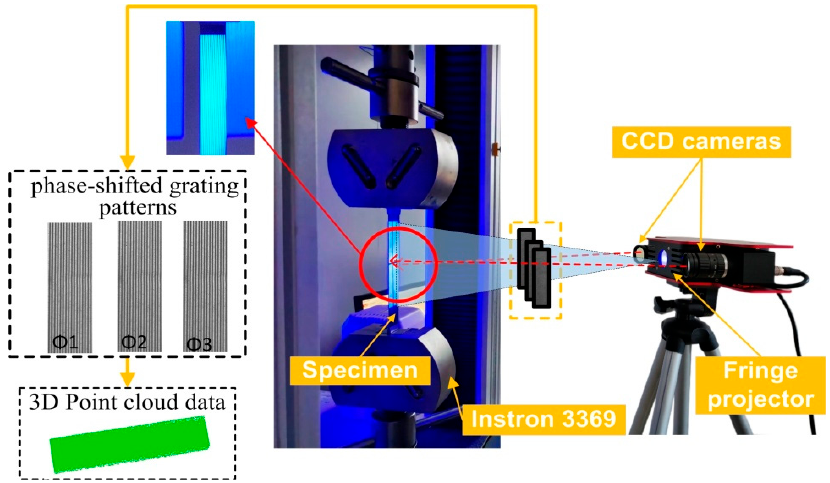
Figure 12. 3D topography measurement based on fringe projection.